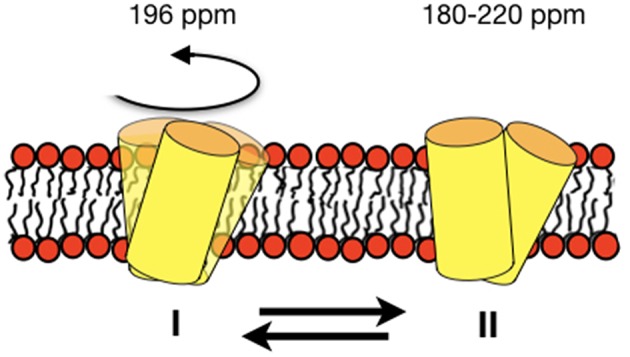
Schematic representation of an equilibrium between a fast-moving monomer and a less dynamic dimer of DQB1 is shown although the exact size of the complexes remains unknown from the experiments presented in this paper. The corresponding 15N chemical shifts are indicated on top of the membrane.